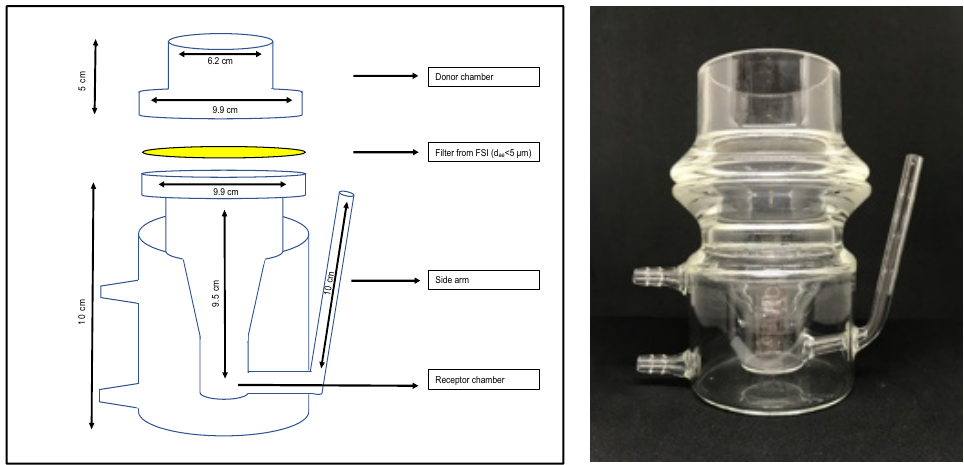
Figure 1. From the left, schematic representation, measurements and pictures of RespiCell™ apparatus.